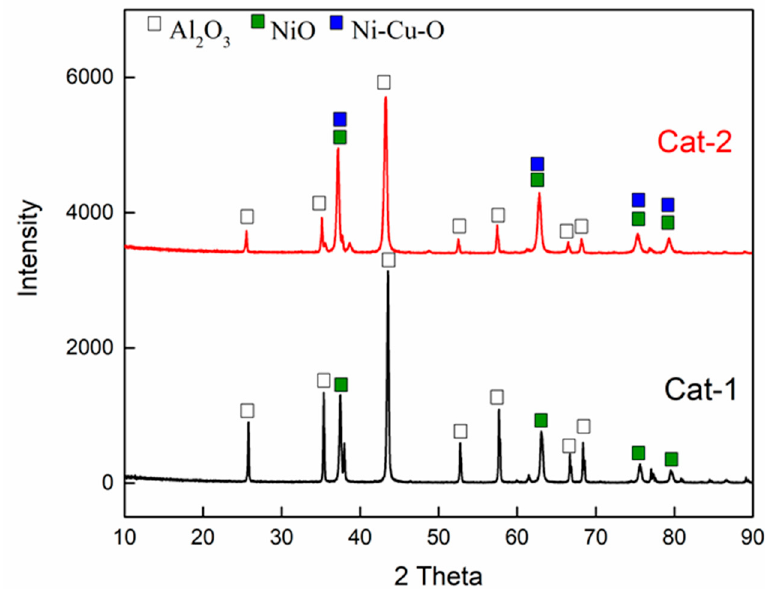
Figure 1. X-ray diffraction for a fresh catalyst.